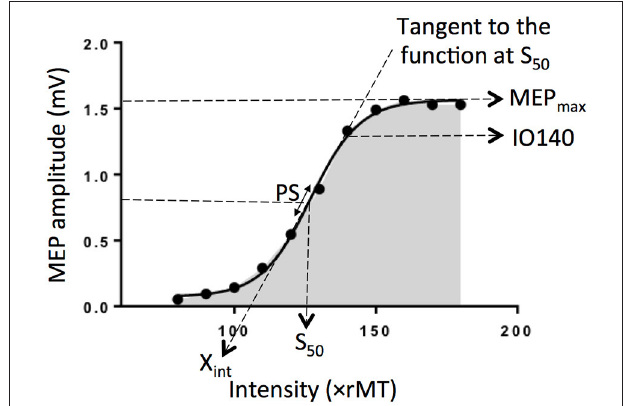
FIGURE 1 | Electrophysiological parameters extracted from an example of an input output curve (I/O curve) fitted by a sigmoid function. Are shown